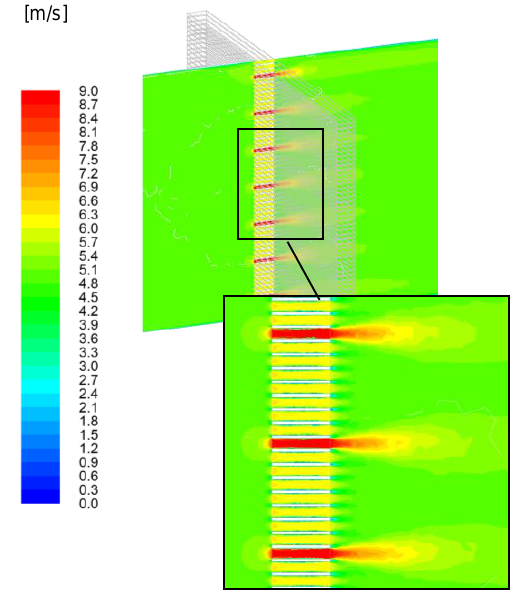
Fig. 9. Velocity contours in vertical section through the exchanger in the axis of the sensor